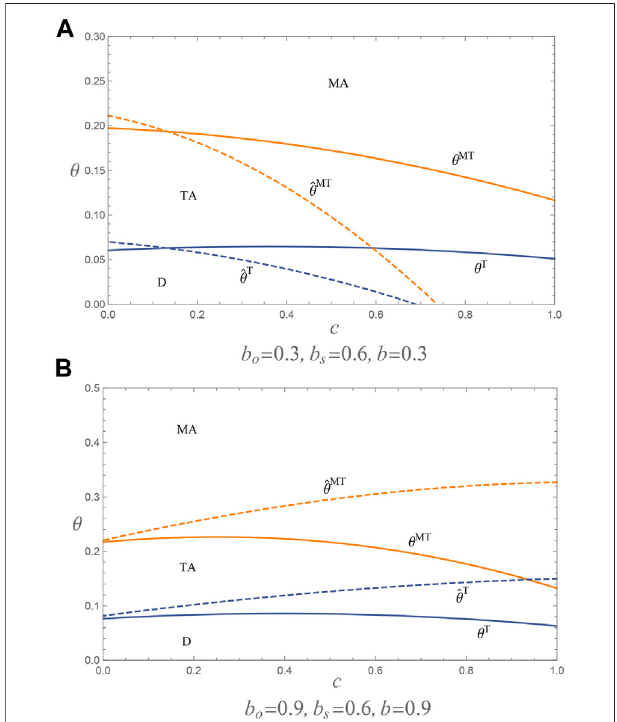
FIGURE 6 | Optimal channel strategy in symmetric and asymmetric in differentcase: (A) a =1, b o =0.3, b s =0.6, b =0.3; (B) a =1, b o =0.9, b s =0.6, b =